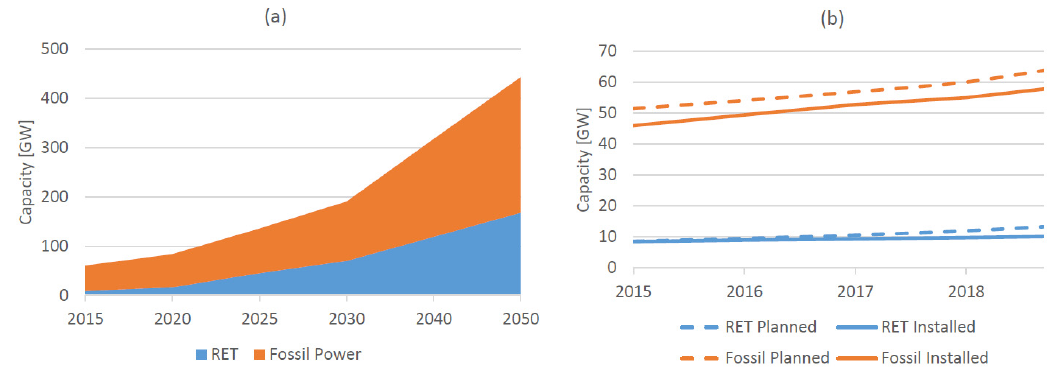
Figure 3. ( a ) Planned installed capacity based on RUEN [5] and ( b ) installed vs. planned capacity of fossil and RET until 2019 [2,5].